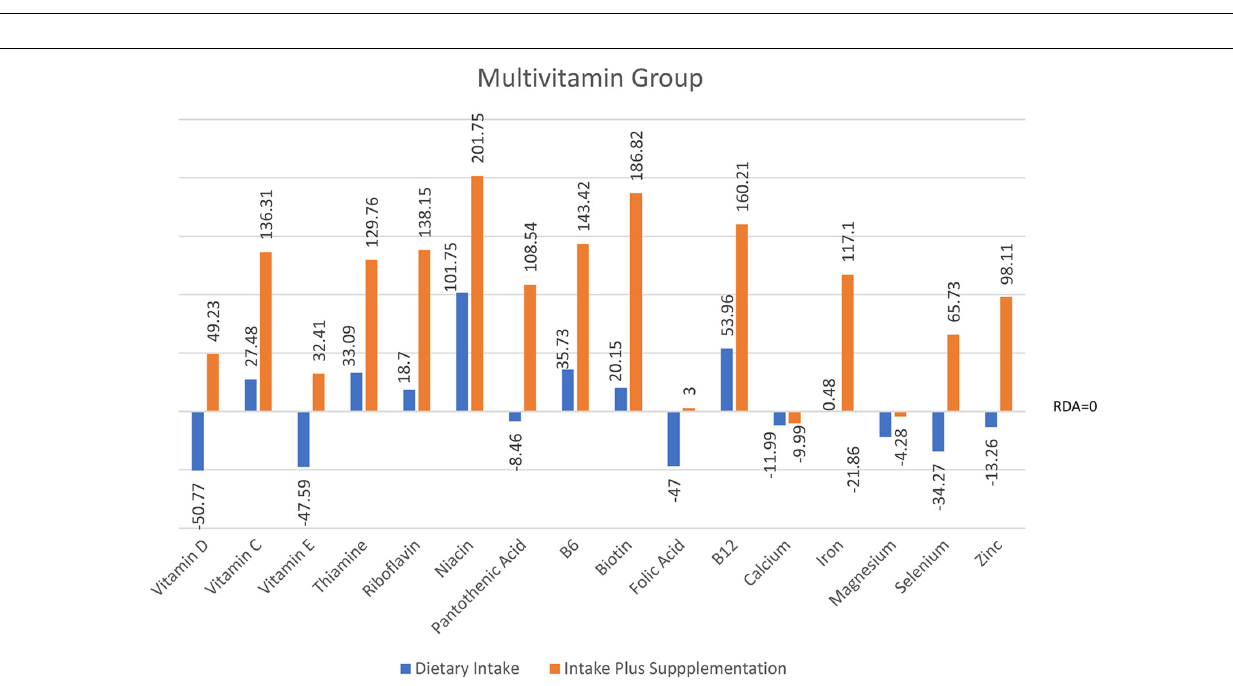
FIGURE 4 | Intake of micronutrients in the Multivitamin group pre- and post-intervention ( n = 20).